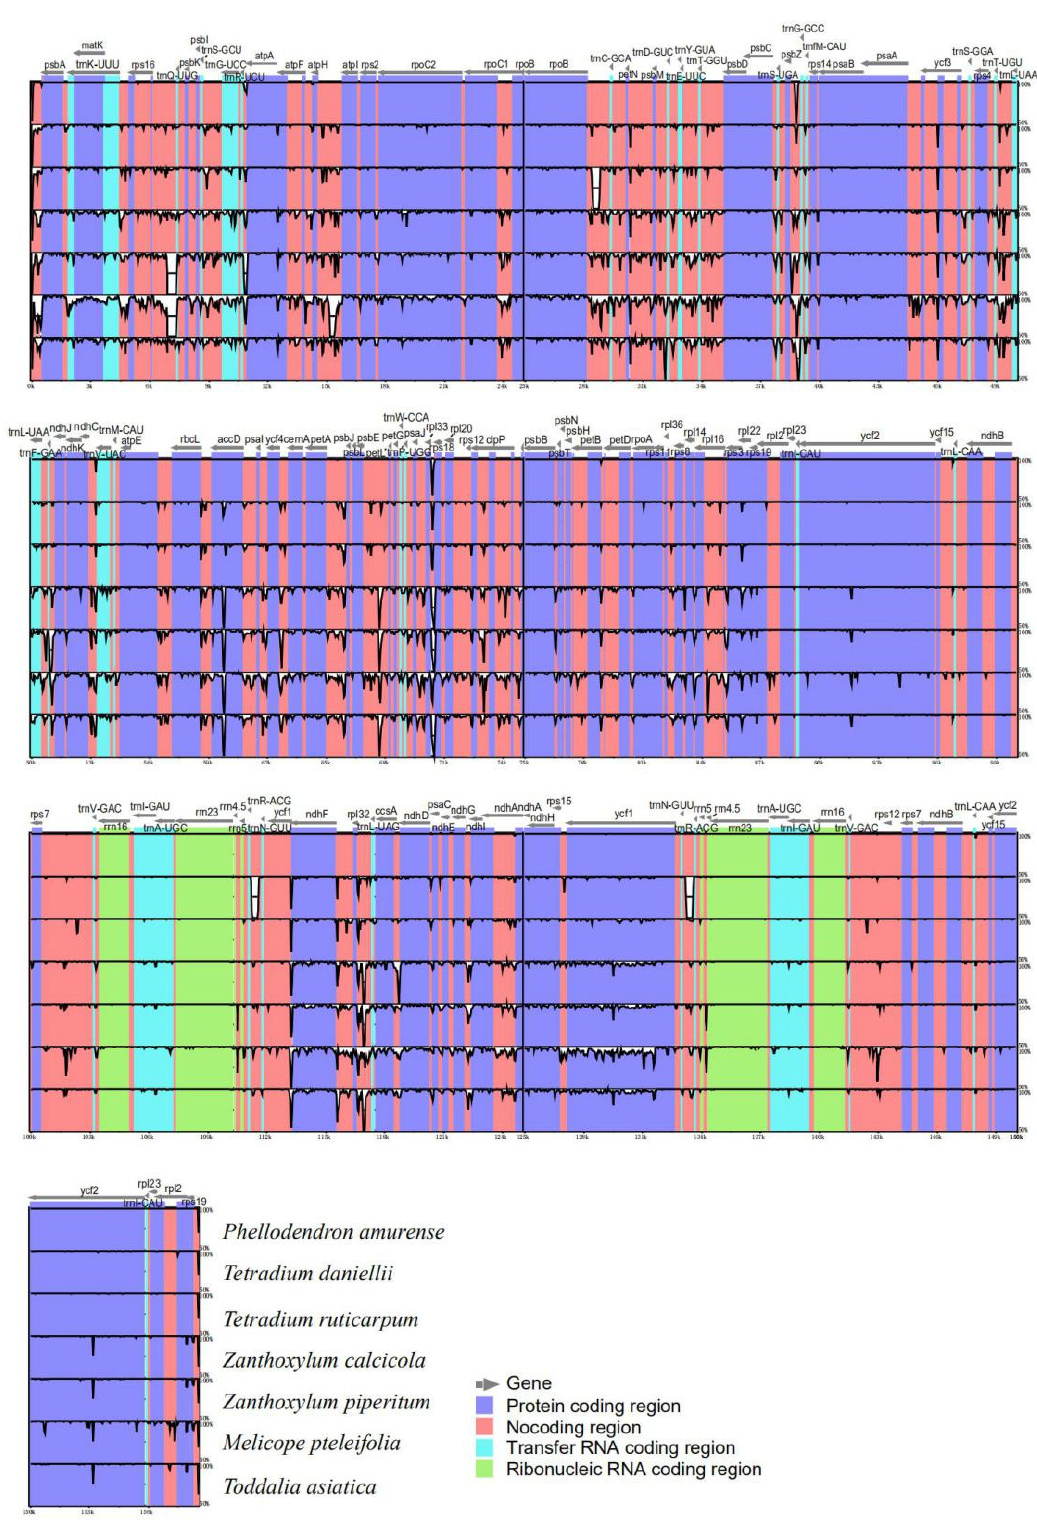
Figure 4. Sequence alignment of plastomes of the eight species using the LAGAN method. A cut-off of 70% similarity was used for the plot and the Y-scale represents the percent similarity ranging from 50–100%.